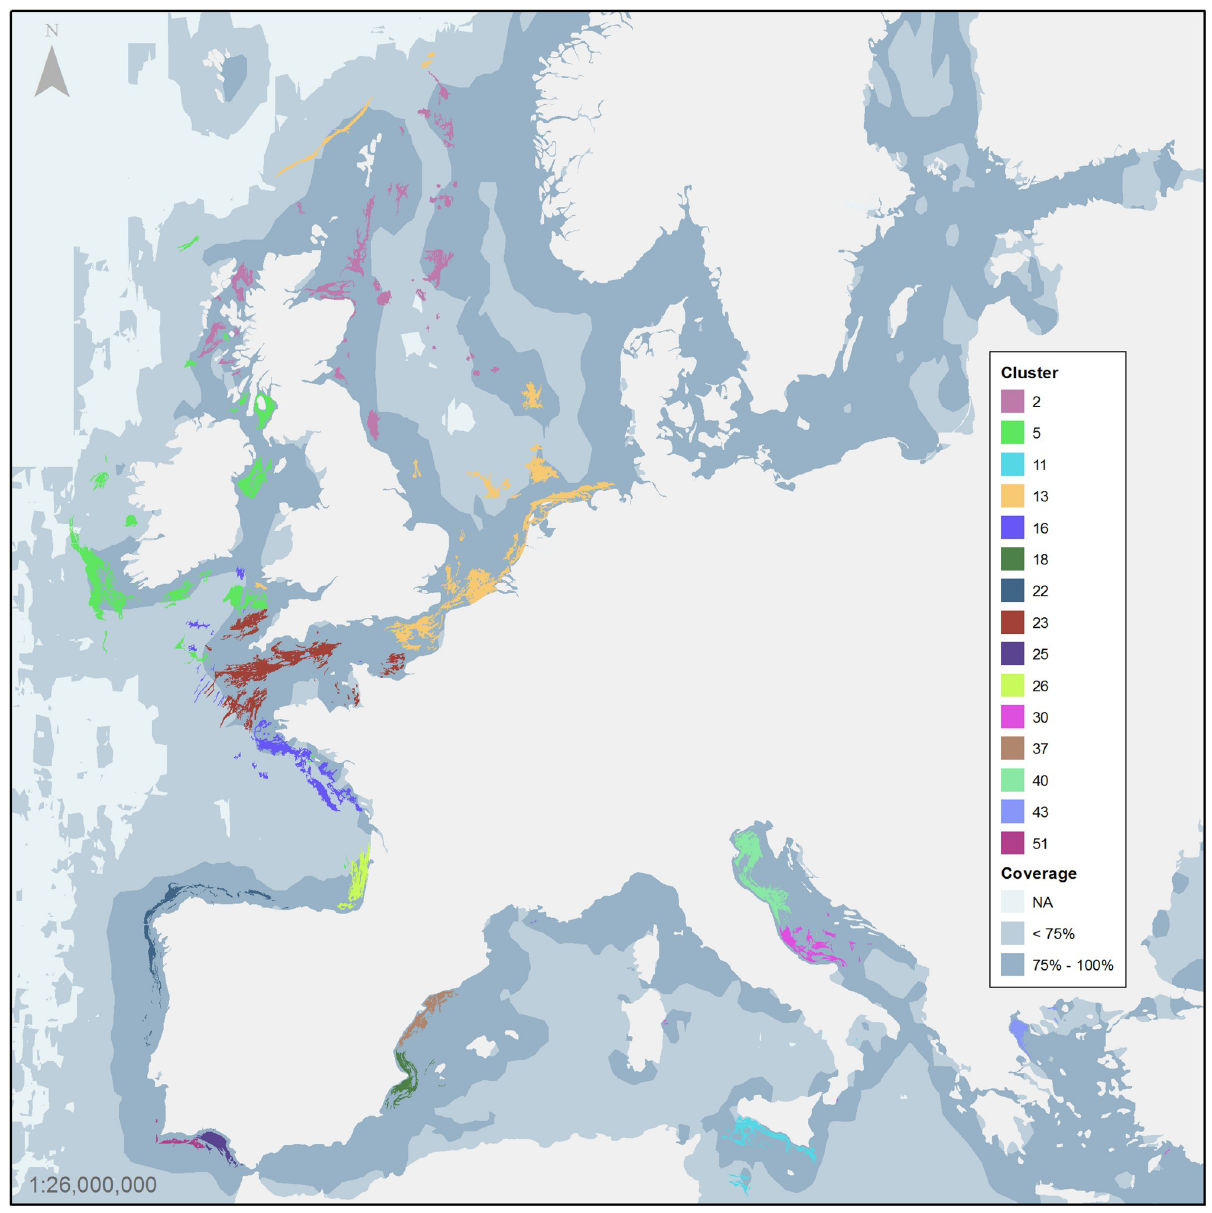
Fig 4. Ports- fishing ground clusters. The map shows the ports and HIFA belonging to the top 15 clusters in terms of employment (see also Table 1). Each cluster is represented by a separate